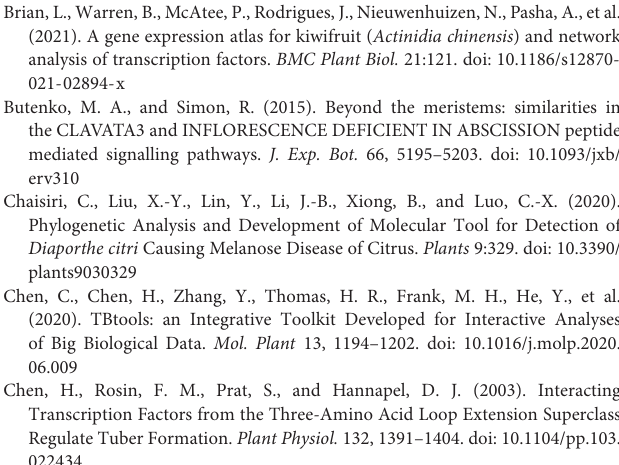
Supplementary Figure 1 | Chromosomal location of CsTALE genes. Left bar represents chromosome length. The chromosome numbers are labeled on left of the chromosomes. Gene density was calculated based on the annotation information within a genomic region. Supplementary Figure 2 | Syntenic relations of the TALE members among Citrus sinensis and three representative plant species. Light-colored lines in the background represents the collinear relationship within Citrus sinensis and other plant genomes, and the deep red lines represent the collinearity of CsTALEs. Cs stands for Citrus sinensis , At for Arabidopsis thaliana , Os for Oryza sativa and Pt for Populus trichocarpa . Supplementary Figure 3 | Diagram of CREs in promoter sequences of CsTALE genes. (A) The box in different colors indicated different CREs. The description of the eight CREs were depicted on the right side. (B) The details of the CREs analysis statistics. Left bar chart showed the total number of each type CREs of the CsTALE genes. Upset plot showed the corresponding CREs of each gene. The black point indicated which sets are included in CsTALE genes. Supplementary Figure 4 | Quantitative real time-PCR analysis of CsTALE gene expression levels in various sweet orange tissues. Heatmap showing the expression of CsTALE genes in different tissues. qRT-PCR analysis of CsTALE genes expression in different tissues. The heat map was generated on the basis of log 2 normalized intensity value. The color bar from blue-to-red indicated expression levels from high to low. Supplementary Figure 5 | The control of yeast two-hybrid analysis. pGBKT7-53/pGADT7-T were used as a positive control. TALE and the empty vector (pGADT7 or pGBKT7) were used as a negative